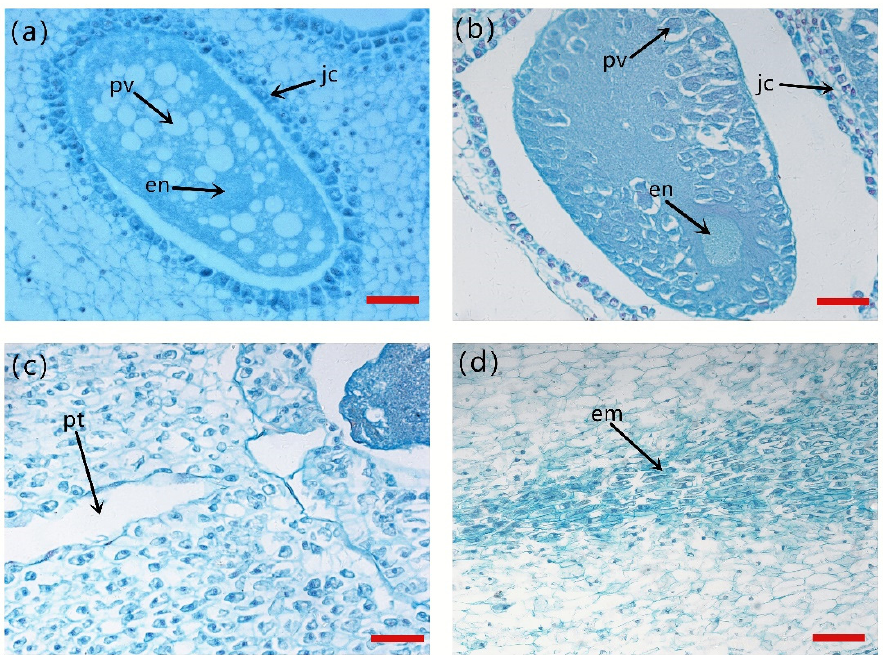
Figure 1. Anatomical observation on ovule fertilization of Korean pine. ( a ) Ovule of Korean pine two weeks before fertilization, bar = 5 µ m; ( b ) Ovule of Korean pine one week before fertilization, bar = 5 µ m; ( c ) Ovule of Korean pine at fertilization week, bar = 5 µ m; ( d ) Ovule of Korean pine one week after fertilization, bar = 10 µ m.